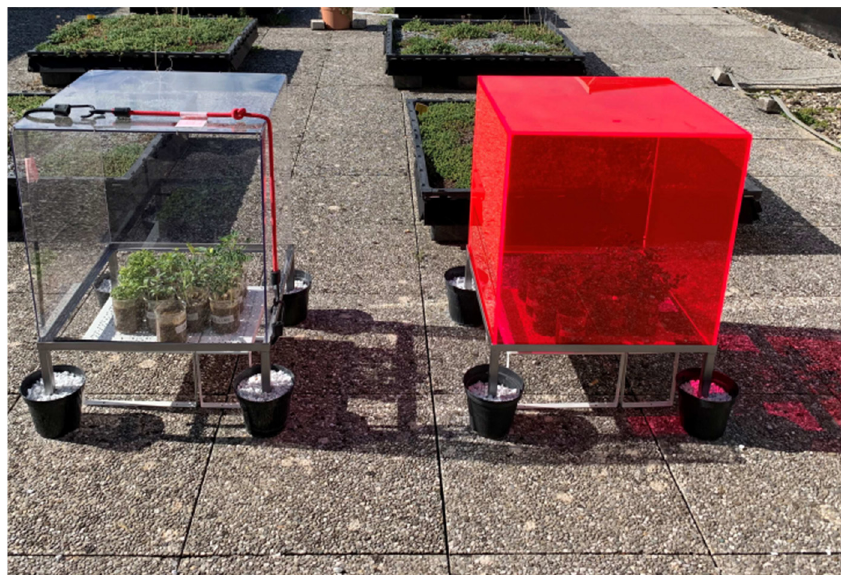
Figure 5. Picture of outdoor experiments. The boxes are made of transparent polycarbonate and red LSC panels. Note: pots filled with white stones at the base of the box structures have the only function of anchoring the panels to avoid possible adverse effects in the event of a mighty wind.